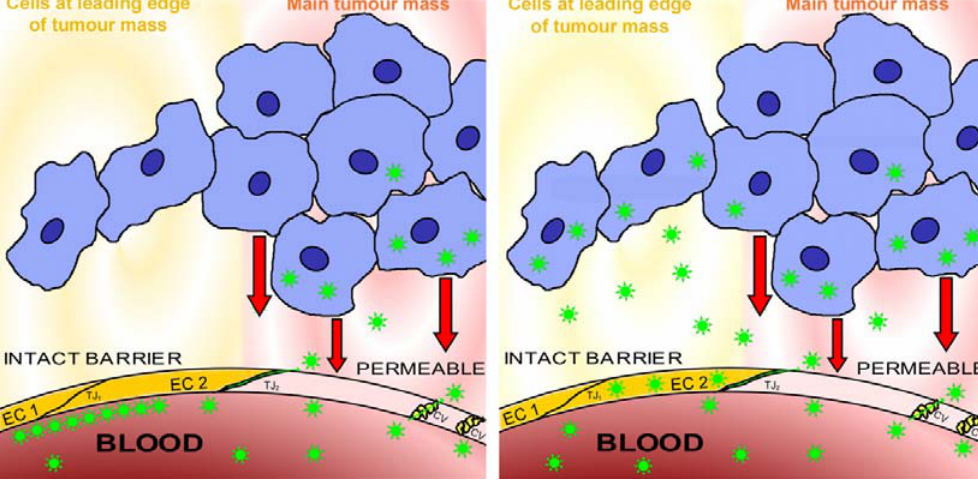
Figure 6. Transbarrier targeting depends on nanoparticles passing through an intact vascular barrier. The image at left shows the present state of the art in nanomedicine. Nanoparticles are prevented from accessing the lesion by endothelial cells maintaining intact barriers, so that no nanoparticles (shown as green stars) penetrate into the perivascular compartment (pale yellow) beyond the barrier-forming endothelial cells EC1 and EC2 (bright yellow to represent barrier function, resulting partly from closed tight junctions such as TJ ). The 1 perivascular compartment is accessed by nanoparticles only at sites (pink) where the endothelial cell layer is permeable (pale pink to represent absence of barrier function, due to open tight junctions such as TJ and to caveolae (cv)), for example where vessels respond to 2 factors such as HIF- α (represented by red arrows), secreted by hypoxic tumours (shown as a mass of blue cells) into their environment. The image at right shows transbarrier passage of the nanoparticles, seen as green stars crossing the barrier-maintaining endothelial cells EC1 and EC2 (yellow). Note that these endothelial cells do not become permeable, but continue to maintain the barrier while the nanoparticles cross them. Once past the intact blood-tissue barrier maintained by the non-permeable endothelial cells, the nanoparticles enter the interstitium behind the barrier, the protected state of this interstitium is denoted by yellow shading. Behind the barrier, in the protected interstitium, the nanoparticles can access a narrow strand of tumour cells (blue) which are well-oxygenated and release no factors (compare Figure 4). These cells, left alive, would generate metastases, but after being accessed by the nanoparticles they can be destroyed by the drug which the nanoparticles